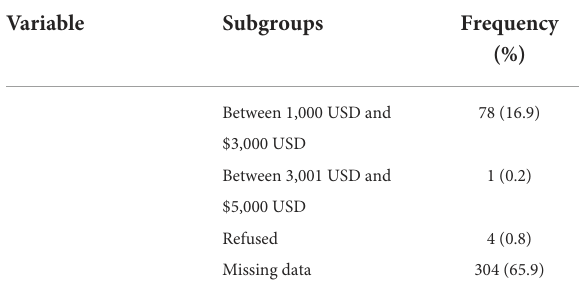
(Figure 1C) (chi-square p -value of 0.00139). We investigated the rate of vaccination and found that residing in Central Arizona (Maricopa County) was associated with a significantly